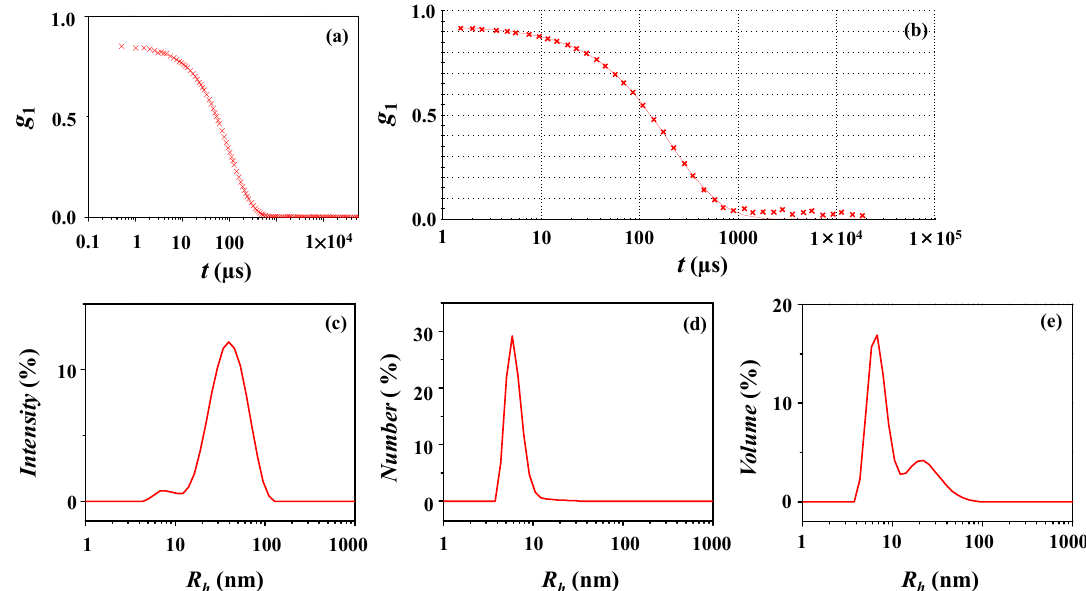
Figure 6. DLS data analysis of the l -PPCGE- b -PDDGE micelle formed in chloroform: ( a ) autocorrelation function profile measured at 25 ◦ C; ( b ) data analysis result, where the symbols are the measured data and the red solid line was obtained by fitting the data using the Zetasizer program; ( c ) intensity-weighted radius distribution obtained by the data analysis; ( d ) number-weighted radius distribution; ( e ) volume-weighted radius distribution. Table 4. Structural parameters of the reverse l -PPCGE- b -PDDGE micelle formed in chloroform, which were analyzed by DLS and X-ray scattering analyses.